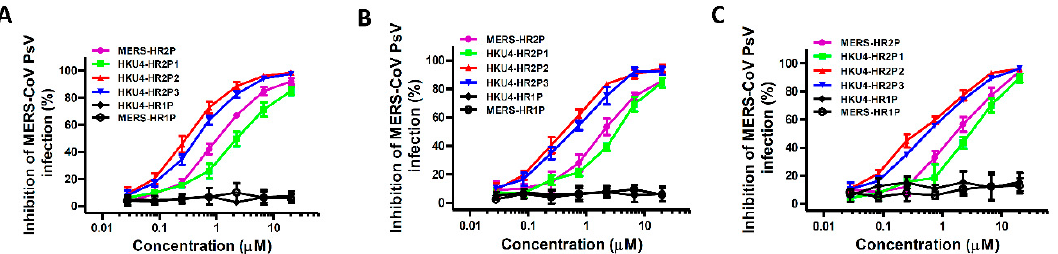
Figure 5. Inhibitory activity of peptides as demonstrated by pseudotyped MERS-CoV infection mediated by S protein ( A ) or S protein with Q1020H ( B ) or Q1020R ( C ). Each sample was tested in triplicate and the data are expressed as means ± SD. Each experiment was repeated twice and similar results were obtained.